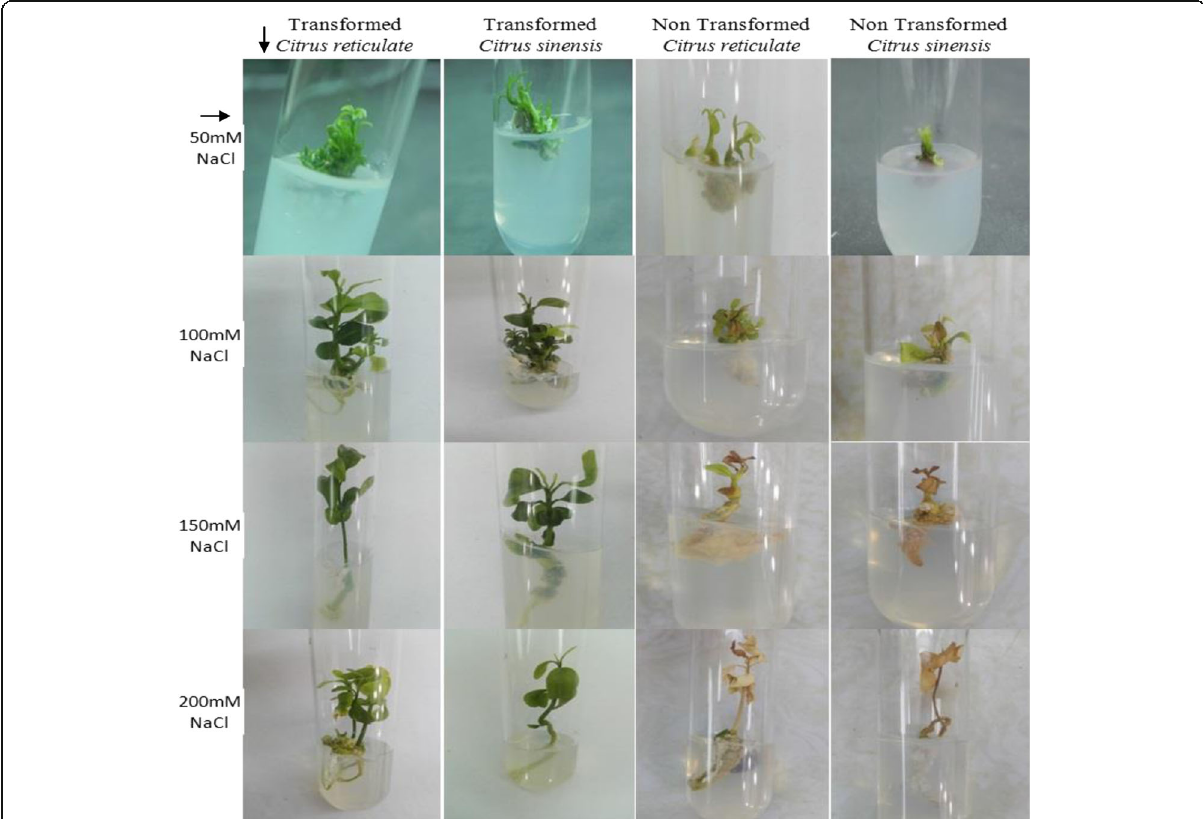
Fig. 9 In vitro evaluation of transgenic and non-transgenic plantlets on MS medium containing different concentration of NaCl and 3 mg/l PEG after 10 days of